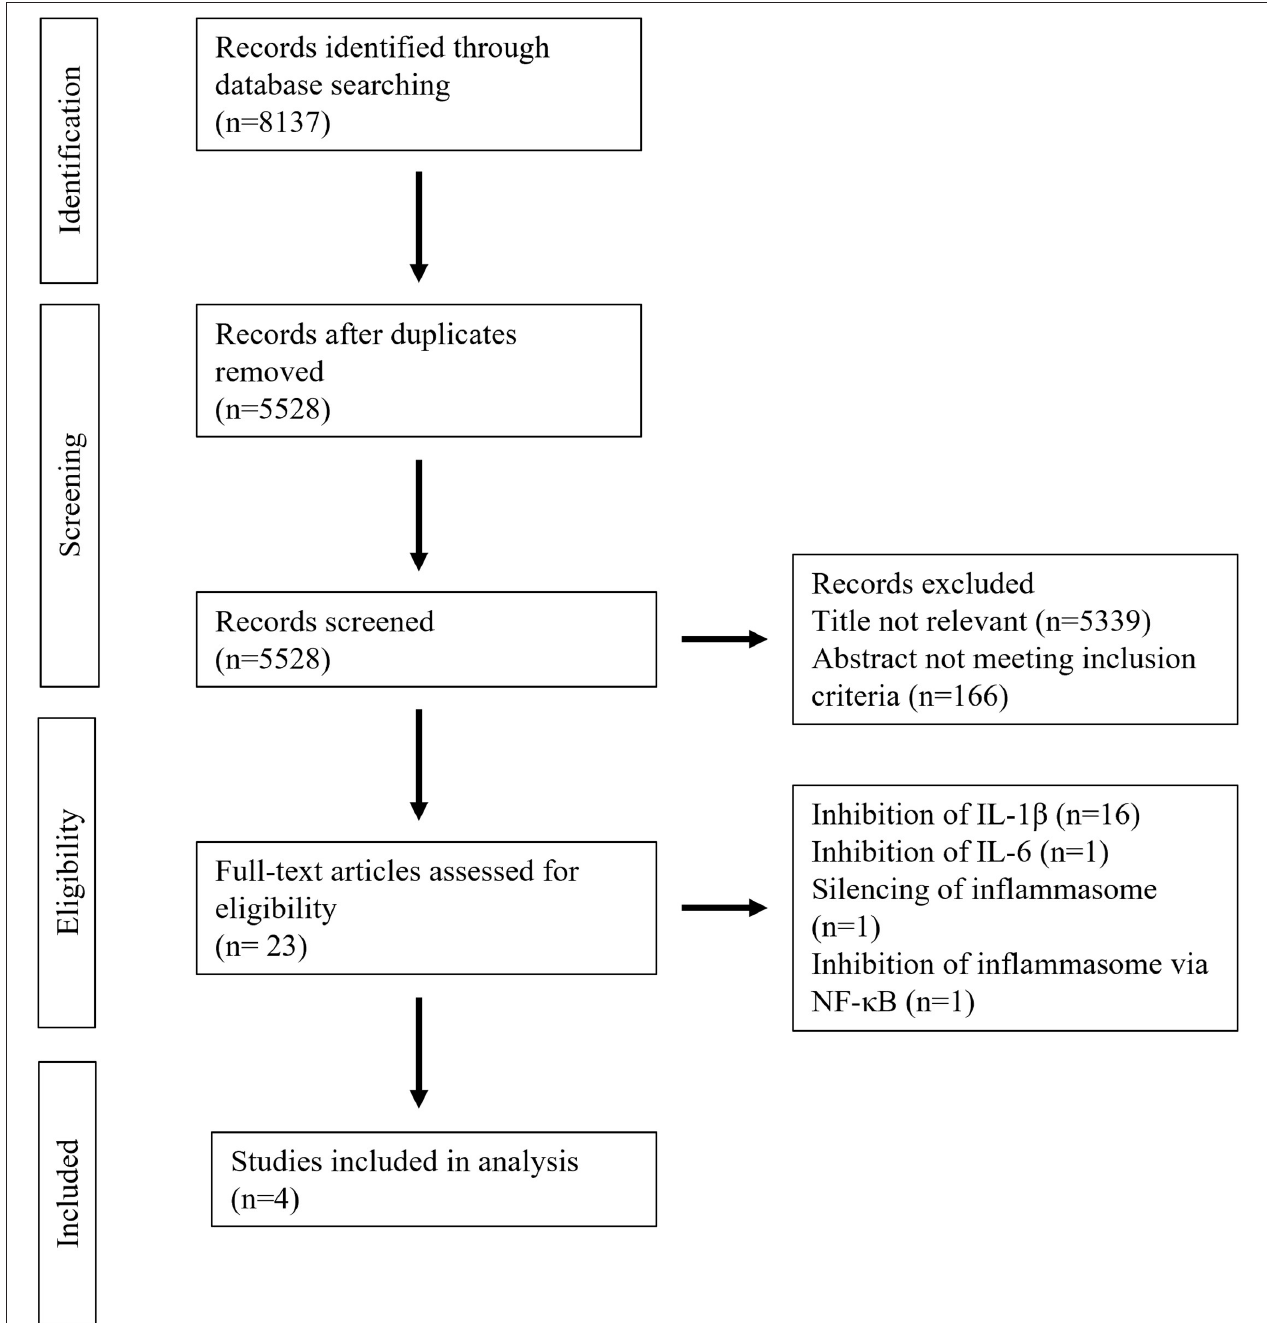
FIGURE 2 | PRISMA flow